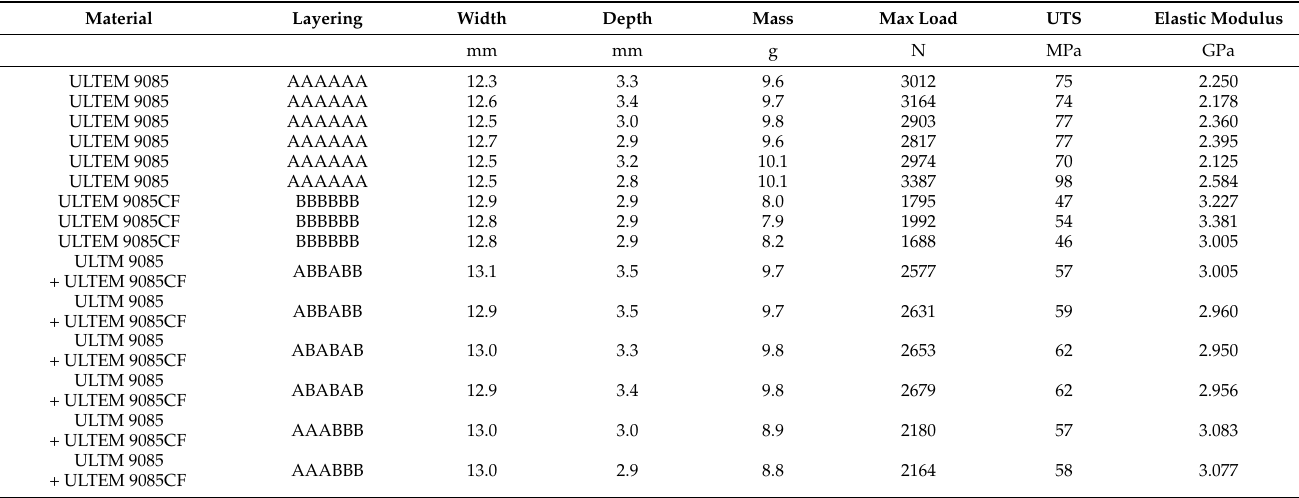
Table A1. Details of all specimens used in this